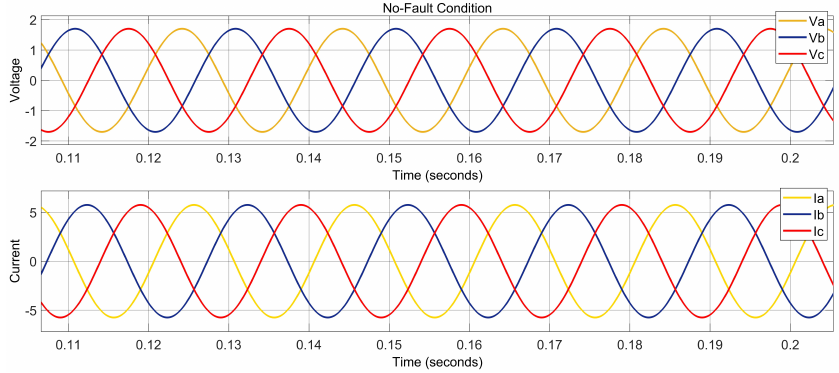
Figure 4. Three -phase at no fault condition. Under the no-fault state, the waveform is sinusoidal and has no distortion due to noise or fault, so the resultant waveform was standard, as seen in Figure 4. When the fault occurred, the fault current of the power transmission line became abnormally high, while the fault voltage decreased to a low value.